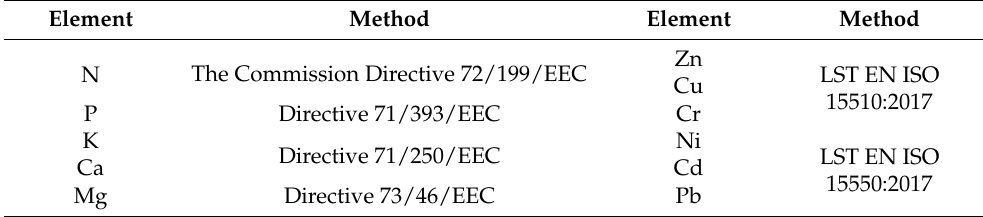
Table 2. Methods by which each element was determined in C. glomerata biomass.